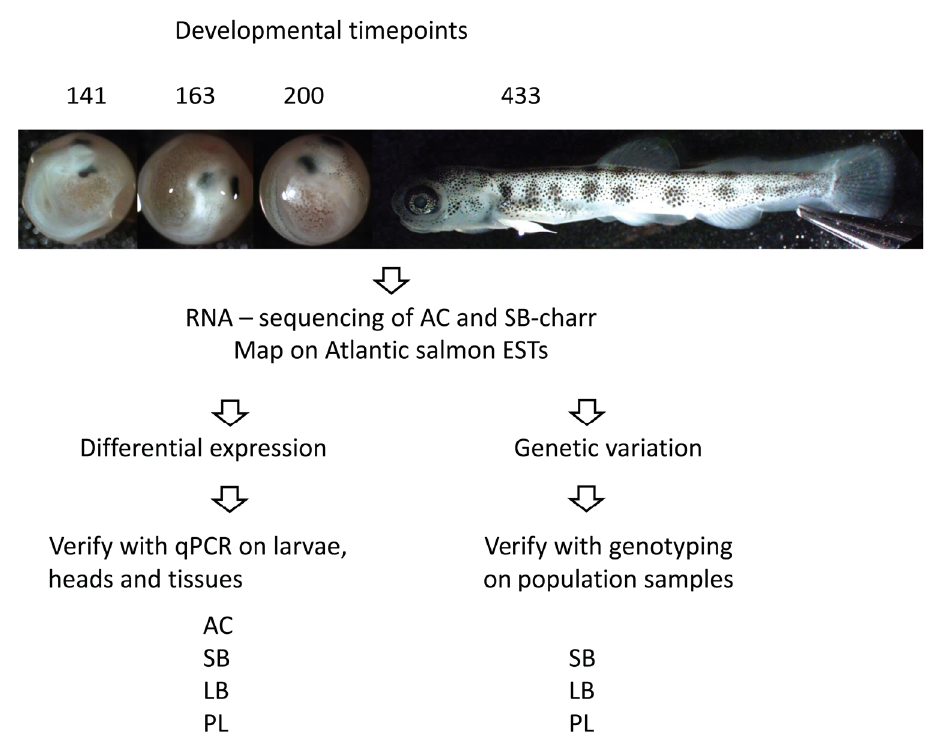
Figure 2. Schematic of RNA sequencing and follow up qPCR and population genetic work. RNA from embryos of the AC and SB charr at four stages (AC embryos pictured at top) were sequenced with Illumina technology. Reads were mapped to Atlantic salmon expressed sequence tags (ESTs). To verify differentially expressed genes we used RNA from embryos and heads of these four morphs, and tissues from adult AC charr. To verify SNPs we genotyped population samples from three Lake Thingvallavatn morphs (PL, LB and